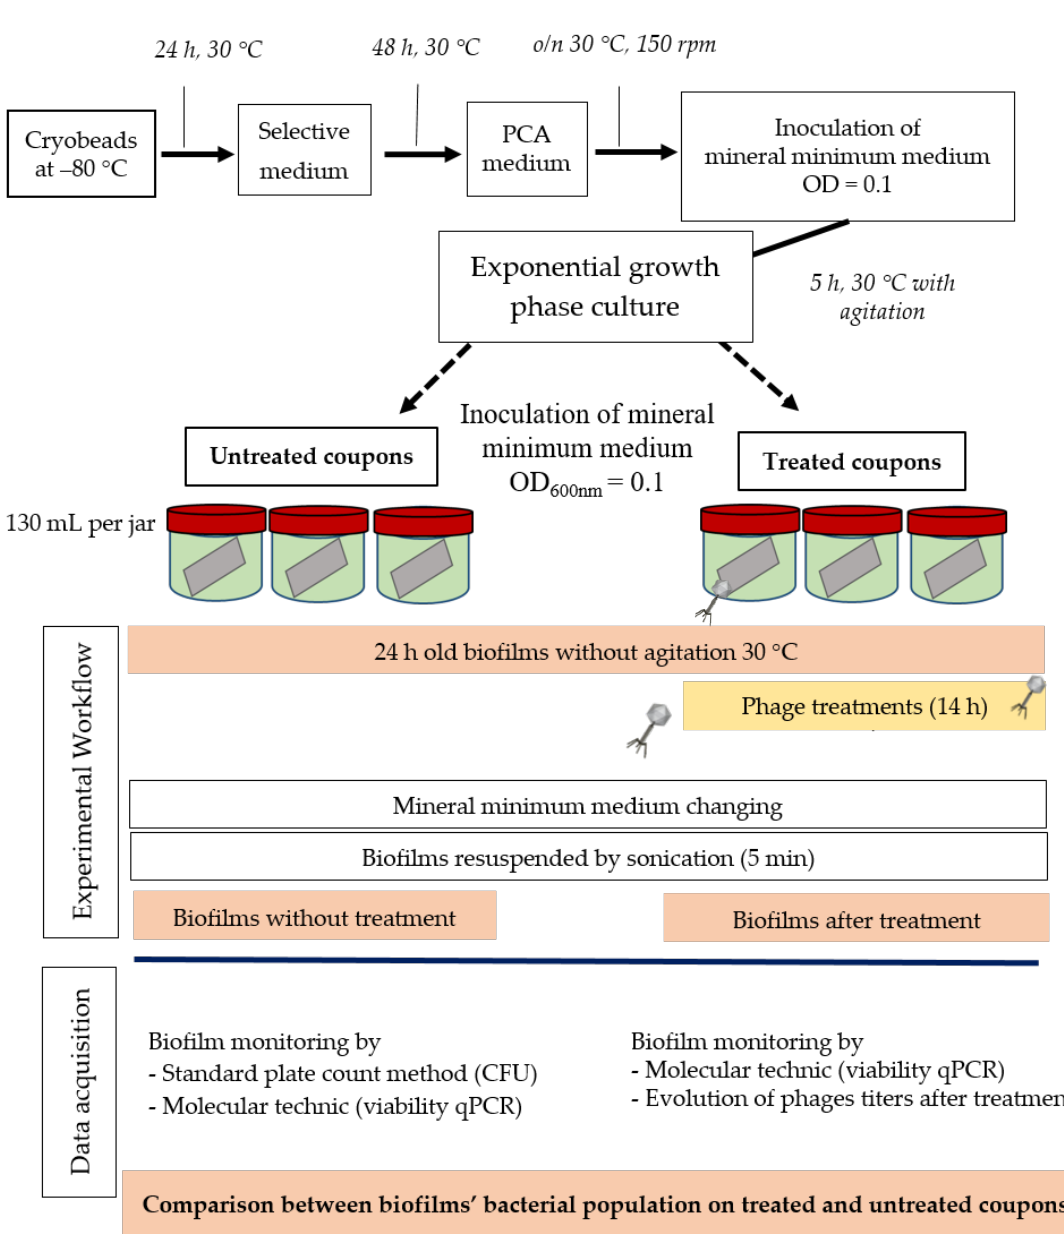
Figure 1. E ffi ciency of viruses’ treatment on P. aeruginosa cells from 24 h old biofilm: Experimental and analytical workflow steps. PCA: plate count agar. OD: optical density. CFU: colony forming unit. qPCR: quantitative polymerase chain